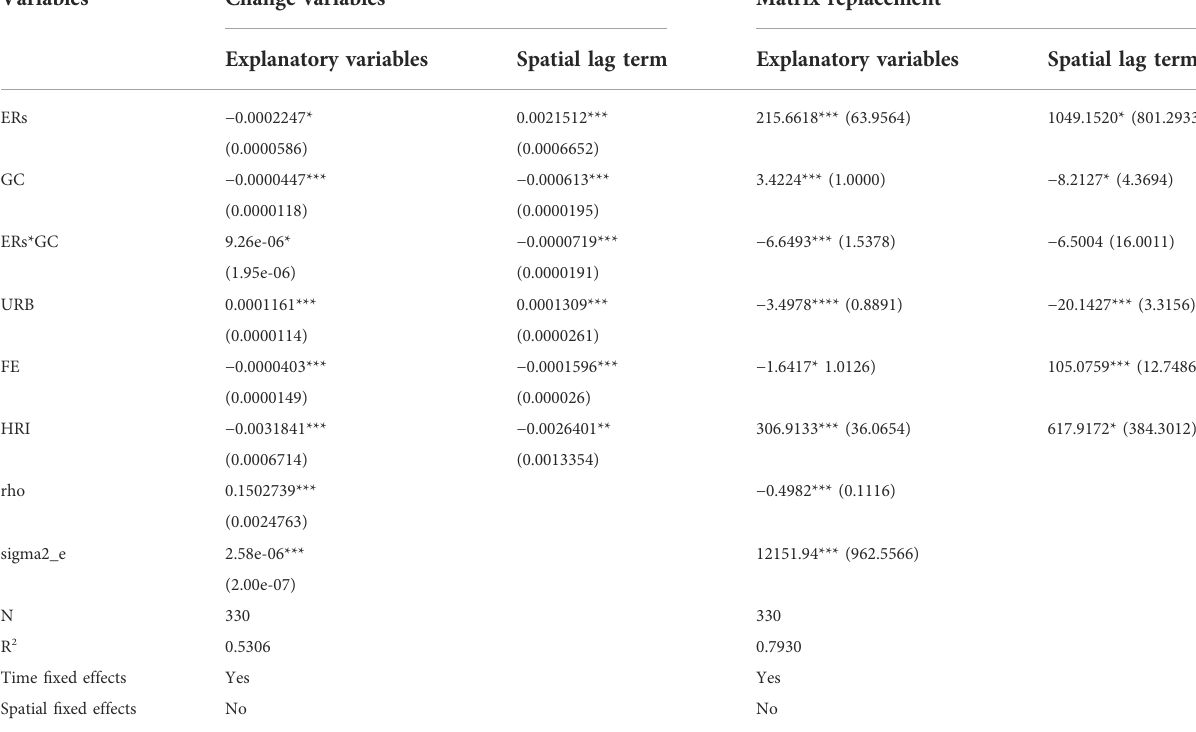
TABLE 6 Results of the robustness